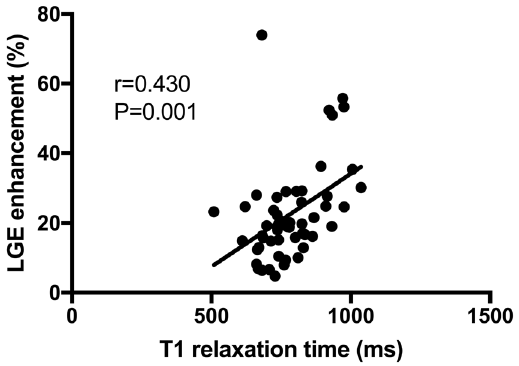
Figure 4. Scatter plot showing correlation between percentage of atrial wall enhancement on late gadolinium enhancement (LGE) images and left atrial T1 relaxations times.